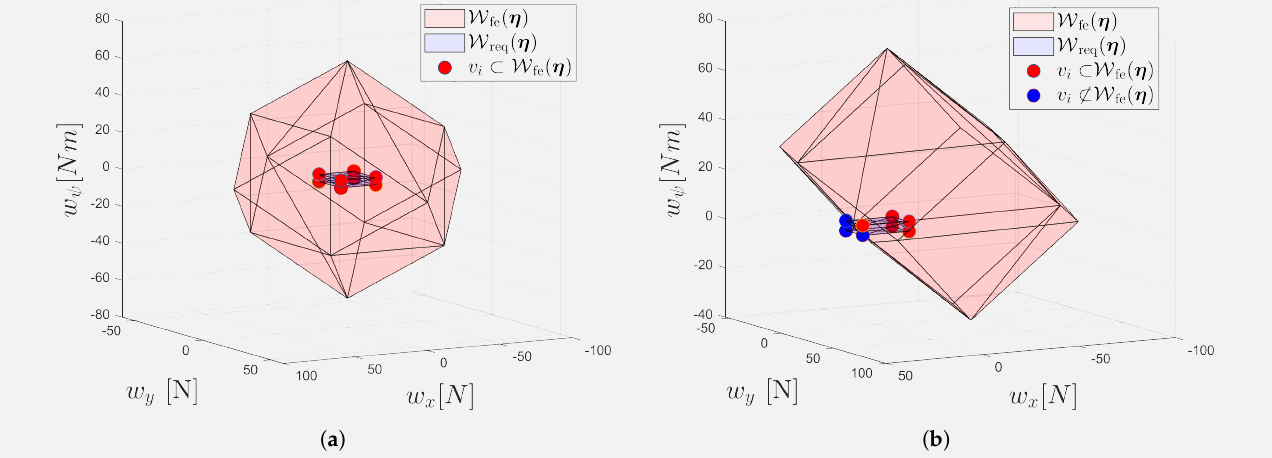
Figure 10. Box load vector requirement W req (blue cuboid), relative to feasible loads W fe (red polyhedron), given (15) for the platform configuration of Table 2. W fe is found by the method described in [42] and computed for illustrative purpose only. ( a ) Platform configuration 1. ( b ) Platform configuration